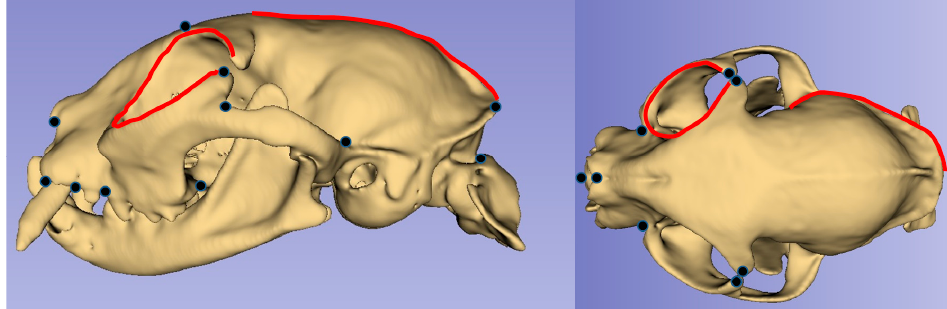
Figure 1. Landmarks and